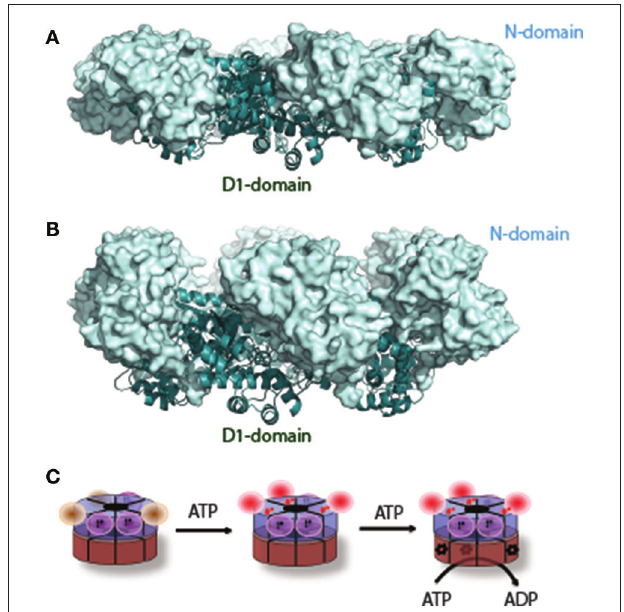
FIGURE 2 | A nucleotide-dependent N-domain conformational change. (A) When ADP is bound to the D1 domain in ribbon diagram in cyan, the N-domain (in light-blue surface representation) assumes the Down-conformation (PDB: 1E32, wild type N-D1). (B) When ATP is bound to the D1 domain, the N-domain moves to the Up-conformation (PDB: 4KO8, R155H mutant N-D1). (C) A schematic model of the N-D1 conformational change upon D1 ATP hydrolysis. The p97 hexamer is represented as two concentric rings with D1 in blue and D2 in brown. The N-domains in the Down-conformation are shown as magenta balls and their cognate D1 domains are occupied with occluded ADP (labeled D). D1 domains with empty nucleotide-binding pockets are not labeled and their cognate N-domains are likely to be mobile (brown balls). ATP binding to the empty sites of the D1 domains will lead the N-domains to the Up-conformation. Occupation of ATP to the D1 domain renders the cognate D2 domain capable of hydrolyzing ATP, which is labeled with a red *. The D1 domain probably hydrolyzes ATP once a few D2 domains have been converted to the ADP bound